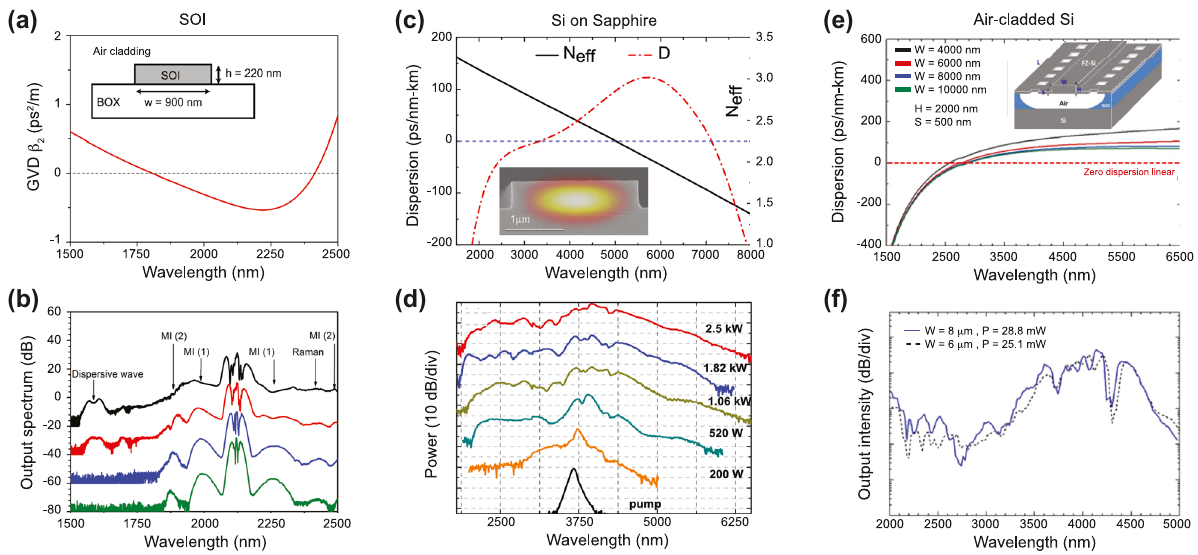
Figure 8: SCG in Si platforms. (a) Calculated GVD as a function of wavelength, inset: schematic of the waveguide and (b) measured output spectrum for coupled input peak power: 3.1 W (green), 4.3 W (blue), 7.9 W (red), and 12.7 W (black). The spectra are vertically offset by multiples of 20 dB for clarity. (c) Calculated dispersion and effective index for SOS nanowire with a cross section of 2.4 μ m by 0.48 μ m shown in inset and (b) measured output spectrum with input peak power ranging from 200 W to 2.5 kW. (e) Calculated dispersion for suspended SI waveguide of thickness (H) 2 μ m, a slab thickness (S) of 0.5 μ m and various height (H), inset: schematic of the suspended silicon waveguide, and (f) measured output spectrum for two widths. Panels (a) and (b) adapted from [64]. Panels (c) and (d) adapted from [67]. Panels (e) and (f) adapted from